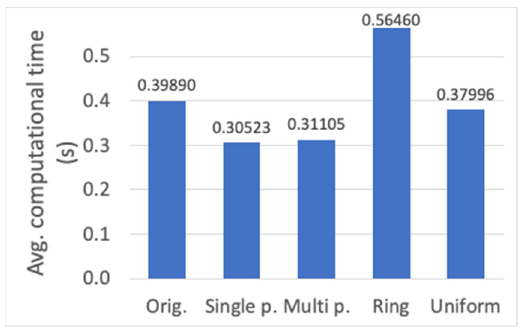
Figure 14. Average computational time (s) for different crossover methods.